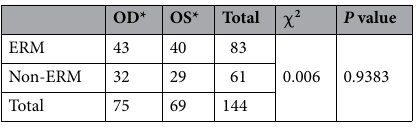
Table 2. OCT diagnosis result. * OD right eye, OS left